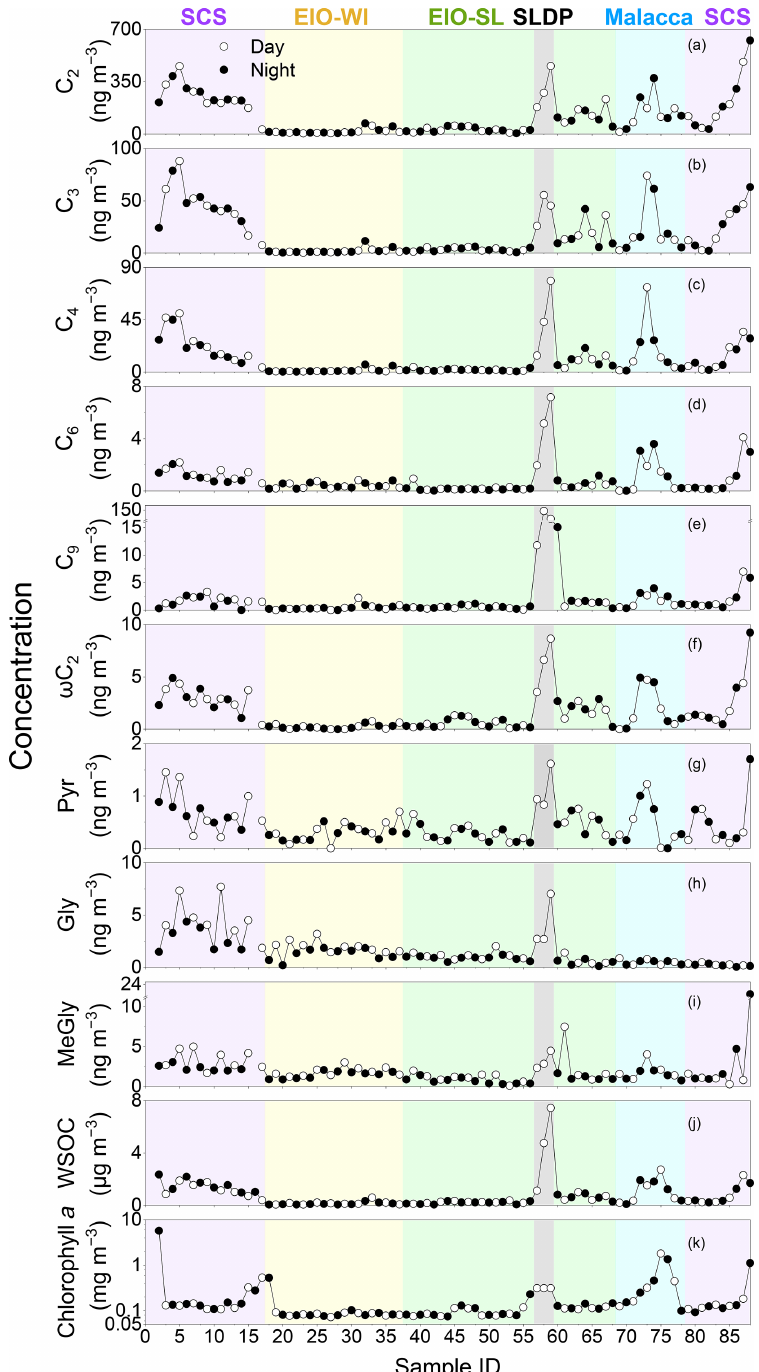
Figure 3. Daily variations in the concentrations of selected organic acids and water-soluble organic carbon (WSOC) in TSP aerosol in the South China Sea and the eastern Indian Ocean from 10 March to 26 April 2015; all parameters are in nanograms per cubic metre (ngm − 3 ) except for WSOC, which is in micrograms per cubic metre (µgm − 3 ) and chlorophyll a , which is in milligrams per cubic metre (mgm − 3